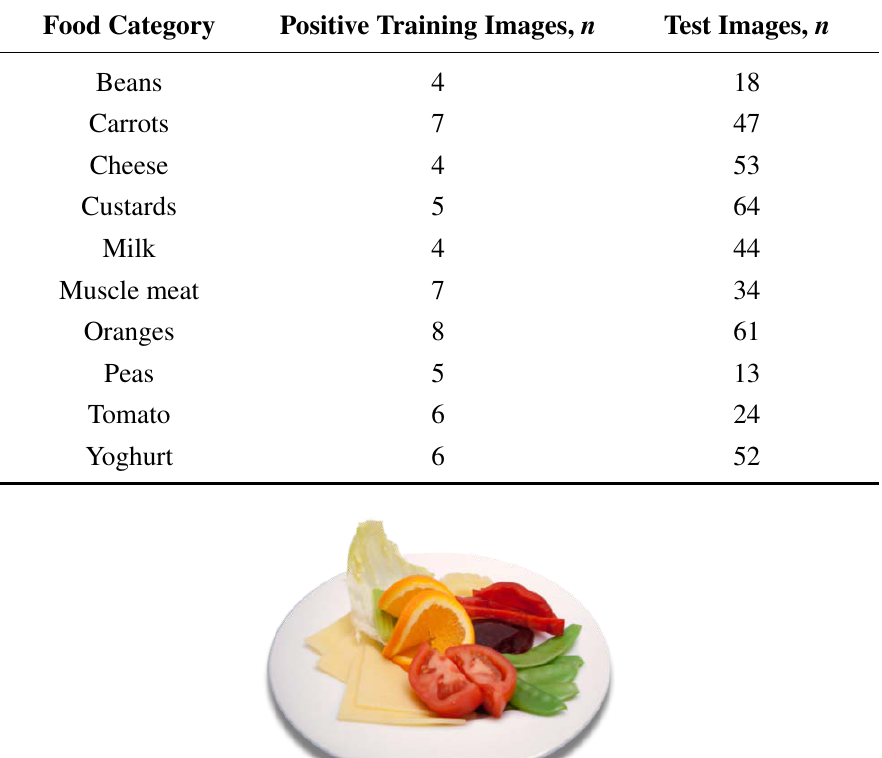
Table 2. Summary of the dataset used for training and testing of the food image recognition method. Positive images of a food category indicate the number of images contained in each food category.